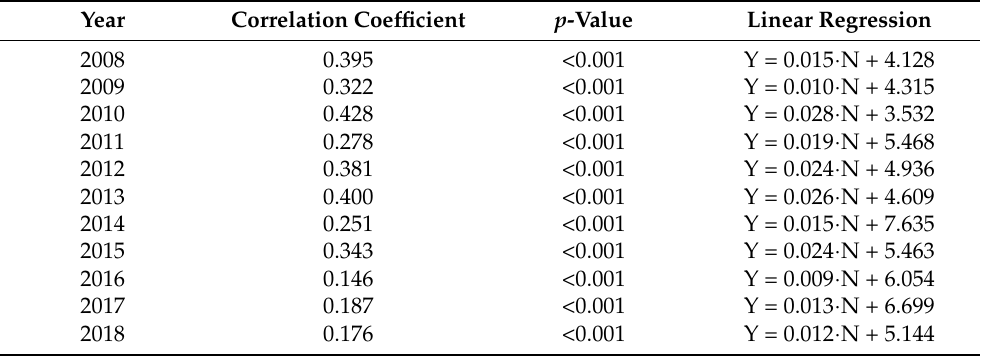
Table 3. Pearson correlation coefficients between wheat grain yield (t/ha) and nitrogen fertilization (kg/ha) for each studied year and linear regression equation presenting yield (Y) dependency on nitrogen (N).